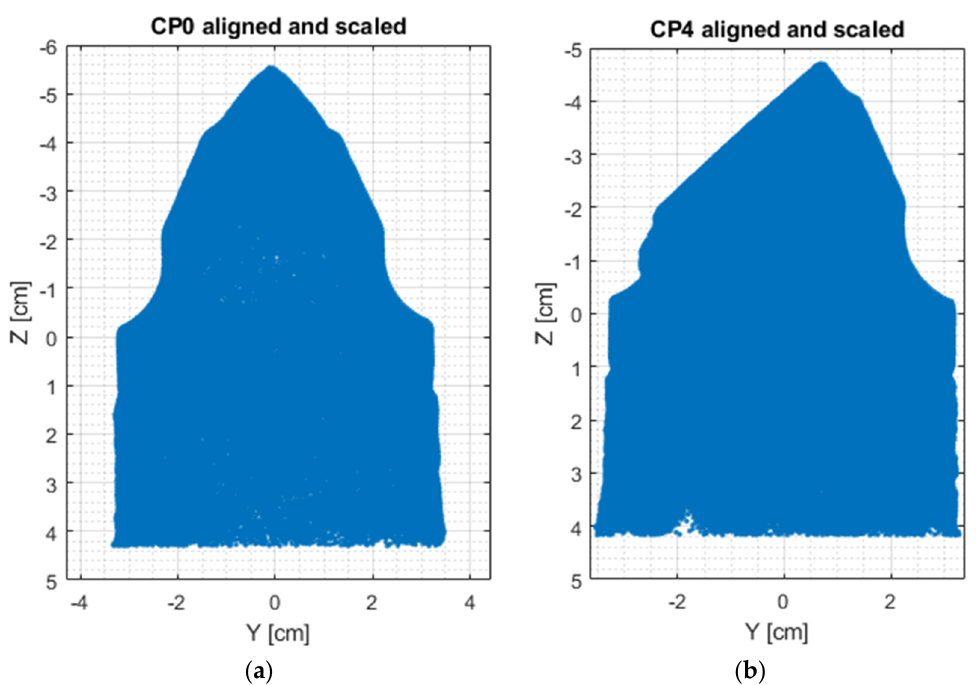
Figure 9. Scaled and cropped data points; ( a )—master model, ( b )—pick after exploitation. The symmetry was calculated for 37 areas of cross-sections of the model with 10˚ of difference between: ϕ = [0˚, 10˚, …, 350˚, 360˚]. The 2D boundary of the model was determined and its area was calculated. Additionally, the plastic deformation area was defined, determining each sum of cross-section boundaries of the master and the rest of the picks (Figure 10). Afterwards, the difference between the summed boundary and the pick’s original boundary was calculated (Table 6). Figure 11 presents the aggregated results for the examined picks.